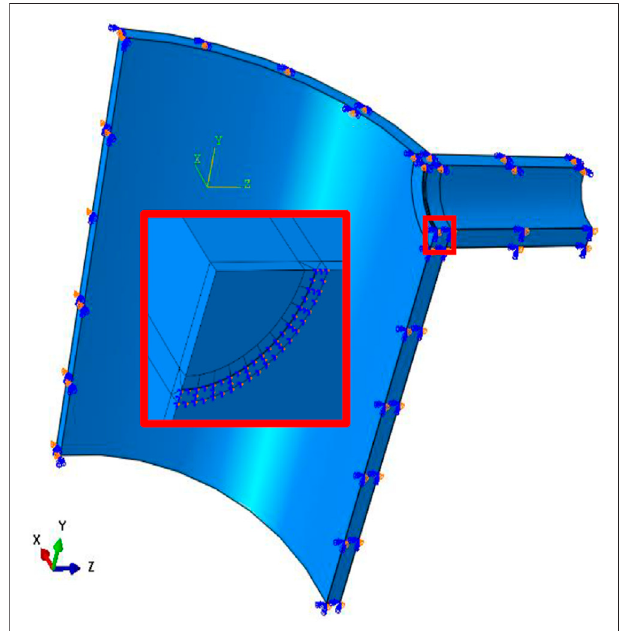
FIGURE 8 | Finite element boundary conditions for 1/4